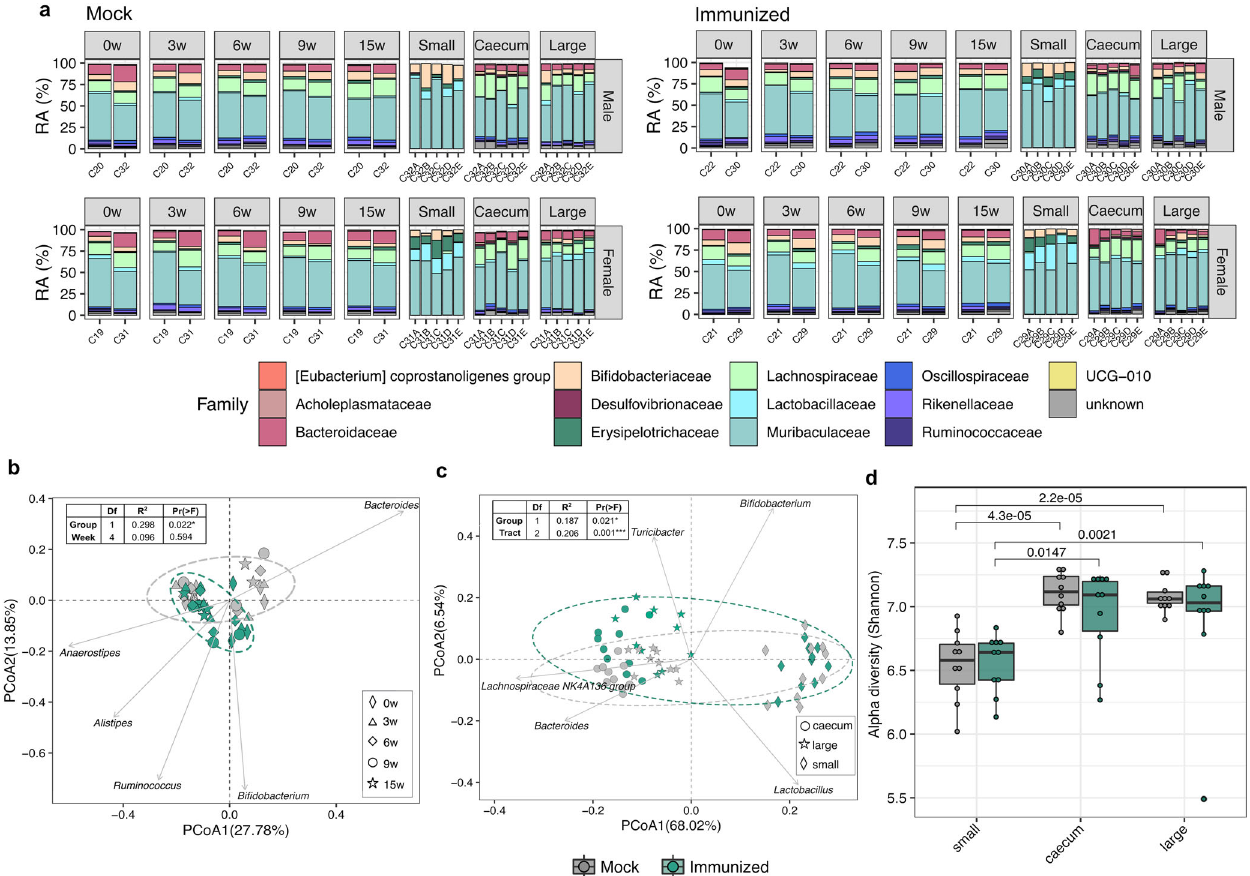
Fig. 2 Temporal dynamics in microbiome composition after vaccination. a Stacked bar chart displaying the relative abundance of bacterial families (top 15 most abundant) at different timepoints in HTI-vaccinated (Immunized) or PBS-vaccinated (Mock) mice. CageID (pooled feces) and individual samples for each cage (intestinal content) are reported in the x -axis. PCoA biplot based on the fi rst and second components (Bray – Curtis distances at genus level) of ( b ) fecal samples from cages ( c ) and from gut sections (small intestine, caecum and large intestine). Biplots report genera with the top 5 effects on the community composition, with vector position indicating the direction of the effect. Arbitrary ellipses were drawn to facilitate the interpretation of the fi gure. PERMANOVA r-squared and p -values are shown. d Alpha diversity based on Shannon entropy index (ASV level) of individual fecal samples obtained at the last point of the study from small intestine, caecum and large intestine. Boxplots are colored by the experimental group. Median values and interquartile ranges are shown in boxplots. p- values from Wilcoxon signed rank tests are